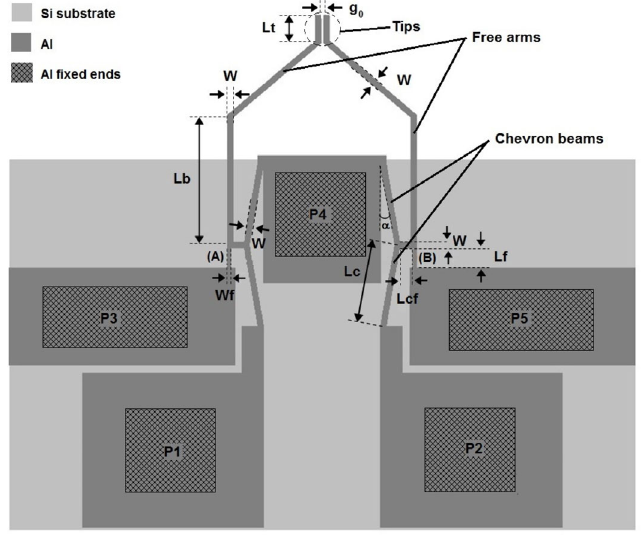
Figure 1. Schematic of the proposed micro-tweezer design: micro-tweezer materials and notations. Table 1. Nominal designed geometrical parameters of the micro-tweezer. Parameter Value Distance between the tips, initial opening, g 0 ( µ m) 10 Length of the tips, Lt ( µ m) 90 Width of the free arms, tips, and chevron beams, W ( µ m) 20 Width of the flexural hinges, Wf ( µ m) 10 Length of the flexural hinges, Lf ( µ m) 78 Length of one chevron beam, Lc ( µ m) 303 Length between the chevron beam and the flexural hinges, Lcf ( µ m) 40 Length of the free arm before it is bent, Lb ( µ m) 460 Angle of the chevron beams, α ( o ) 10 Aluminum thickness, t ( µ m) 2